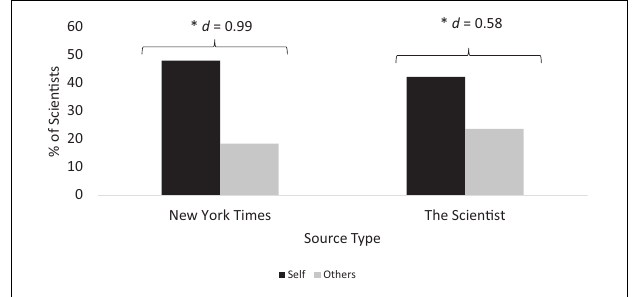
FIGURE 2 | Attributions of overcoming struggles to the self more than to others. Percentages of scientists who attributed overcoming struggles to self or others. ∗ p < 0.05. New York Times N = 27; The Scientist N = 97.